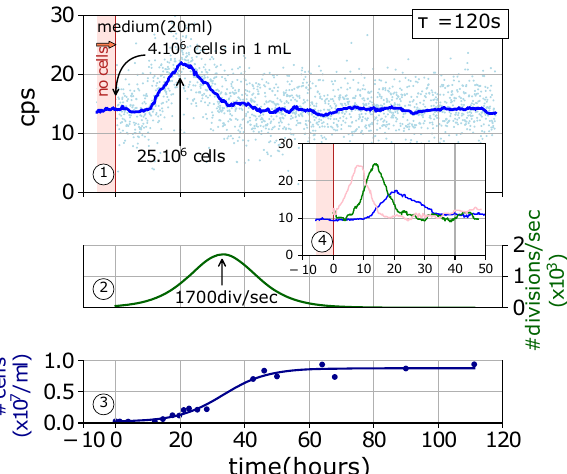
Figure 4. Spontaneous bioluminescence of yeast. Spontaneous luminescence of yeasts growing in liquid culture. Graph no. 1 shows the spontaneous luminescence of yeasts growing in a glucose medium (20 mL). Dots represent the measurement from individual frames and the solid line shows the moving median value over 15 frames. The signal obtained prior to cell seeding indicates the background level. The growth is monitored by counting cells manually (Graph no. 3, blue dots and blue line fit), and the division rate (Graph no. 2) is computed as the time-derivative of the fit of Graph no. 3. Graph no. 4 shows the extent of reproducibility of the experiment with the same BY4742 strain growing in similar conditions, with two similar cameras and a similar integrating